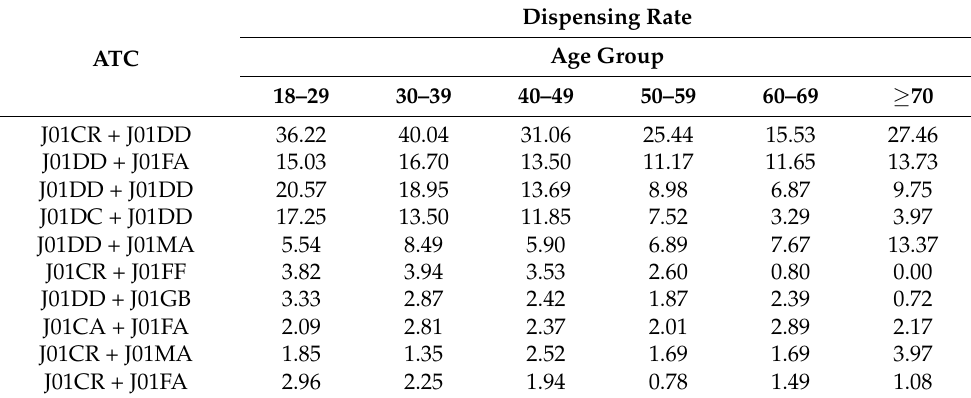
Table 3. Age-standardized rates of use for ten most common antibiotic combinations according to the pharmacological subgroup in different age groups in number of prescriptions per 1000 persons per